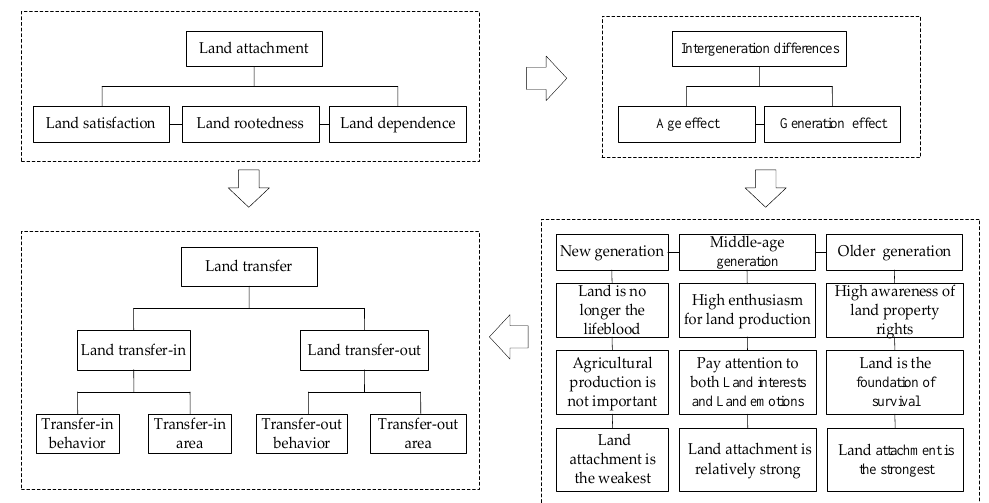
Figure 2. Theoretical analysis framework of this study.